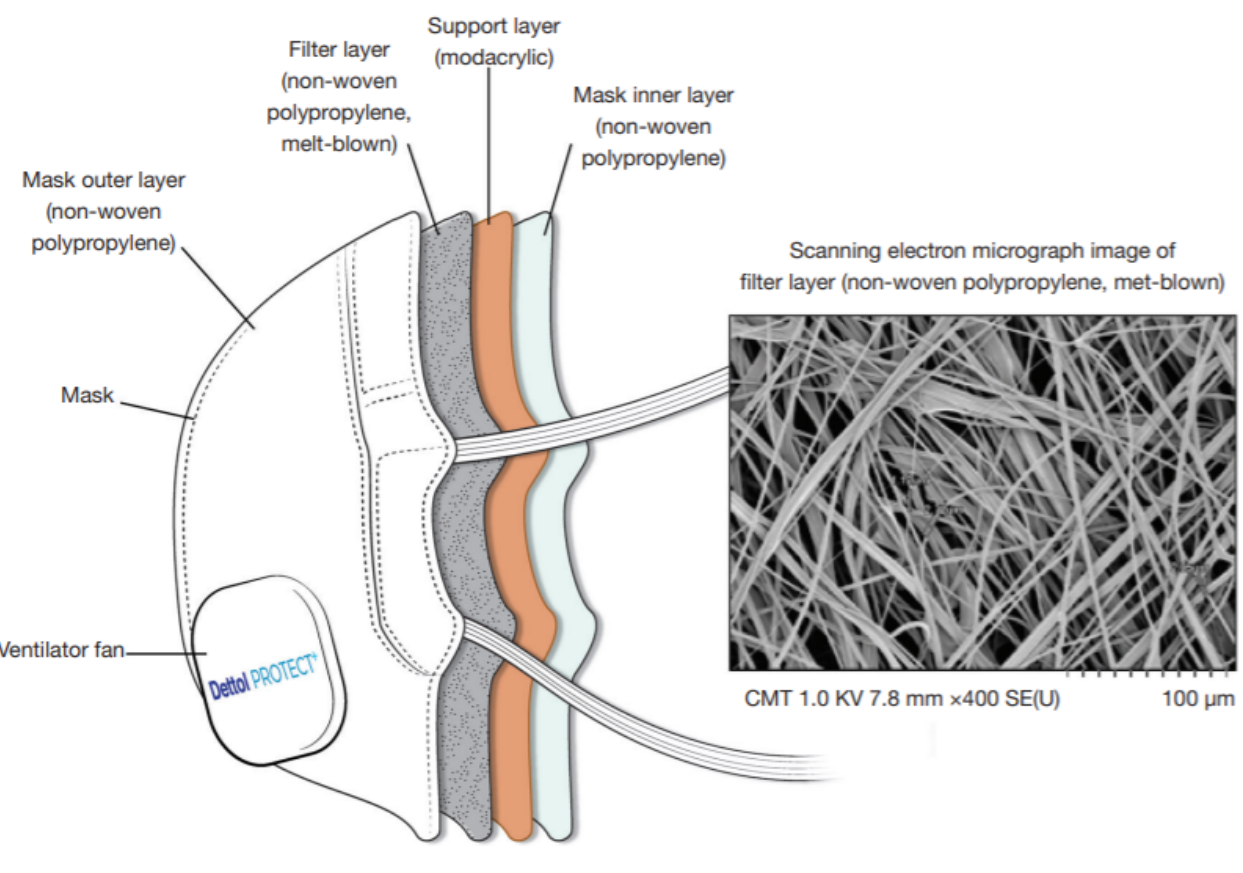
Figure 6. Four-layer N95 respirator mask [69].